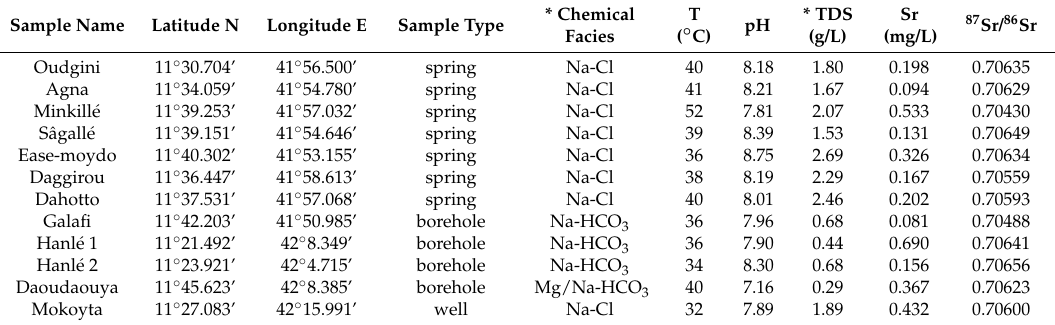
Table 1. The coordinates, strontium concentration, isotope ratio, and principal physicochemical properties of the collected water